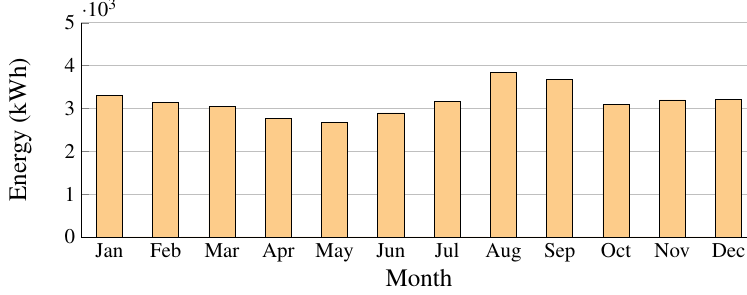
Figure 11. Monthly consumption of PVTL for 2020.